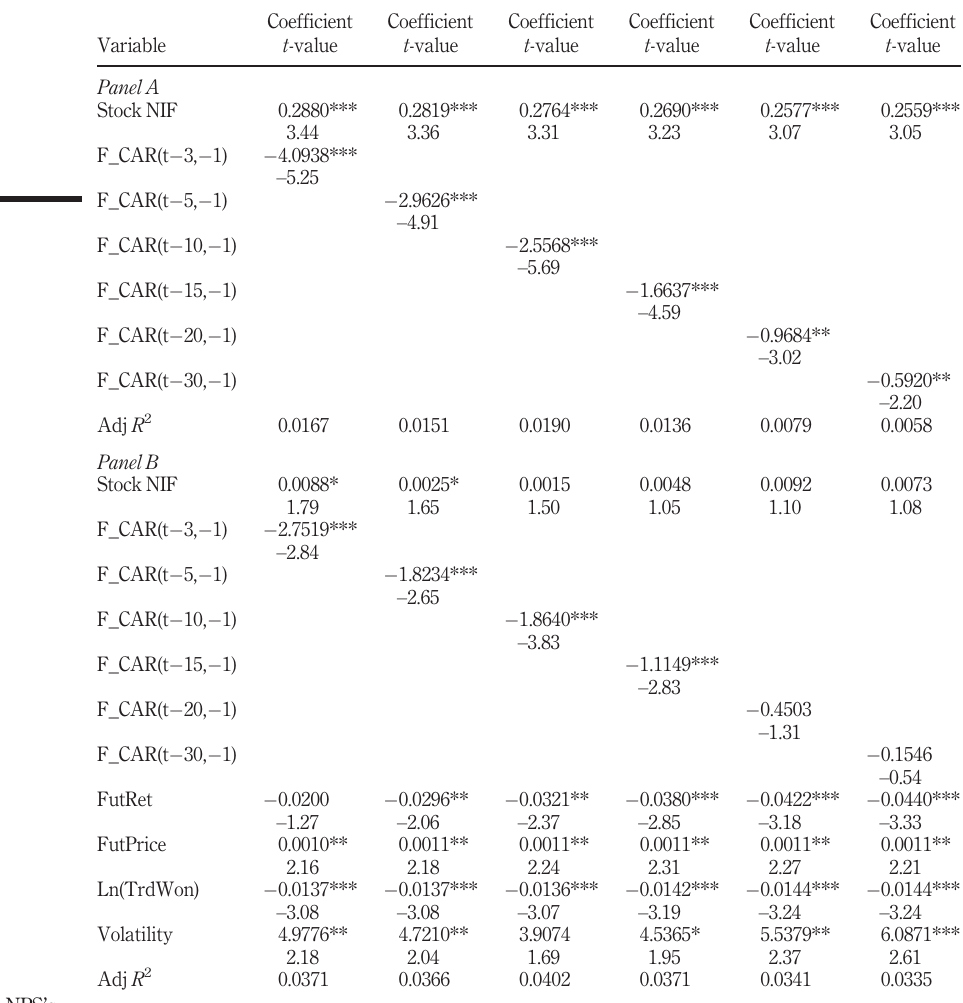
Table 5. Effect of the NPS ’ s NIF in KOSPI200 stocks and the past returns of KOSPI200